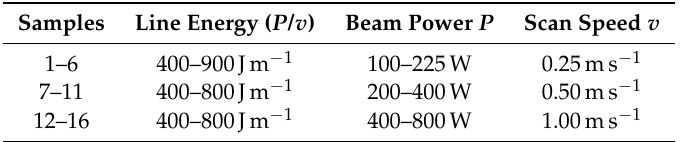
Table 2. Beam parameters for single-line experiments. Line-energy stepping was 100Jm − 1